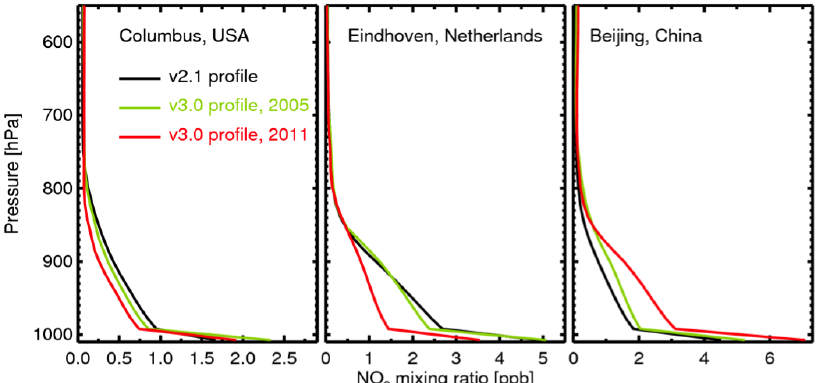
Figure 4. Monthly-averaged vertical distribution of NO 2 in July from GMI over selected locations in the eastern US, western Europe, and China. The color lines show the average NO 2 profiles derived from the new high-resolution (1 ◦ × 1.25 ◦ ) GMI simulation for 2005 (green) and 2011 (red). The black line shows NO 2 profiles derived from previous (SPv2) GMI simulation at 2 ◦ × 2.5 ◦